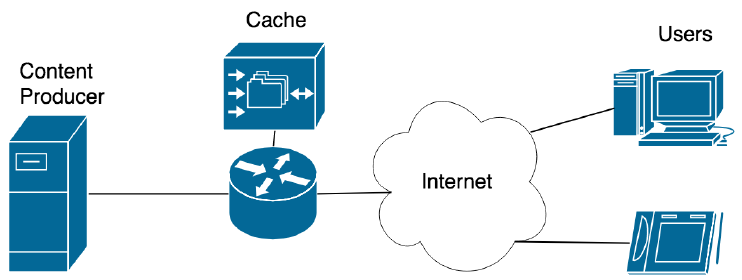
Figure 14. Network reference scenario for caching